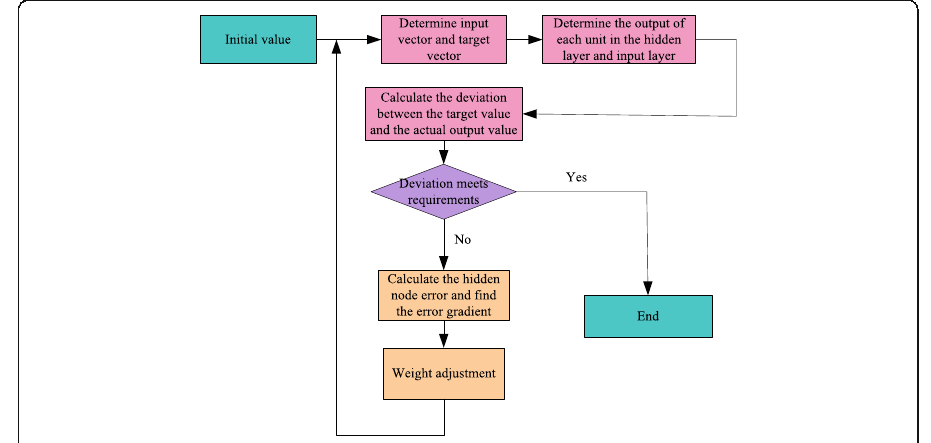
Fig. 1 BP network work flow